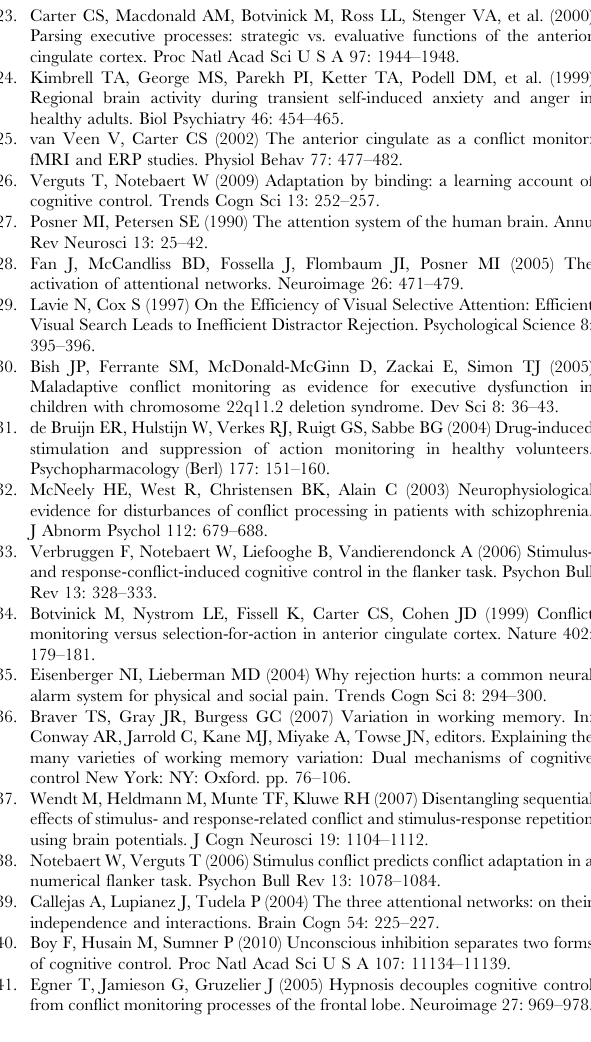
Table S1 The stimuli arrays and transitions used in the